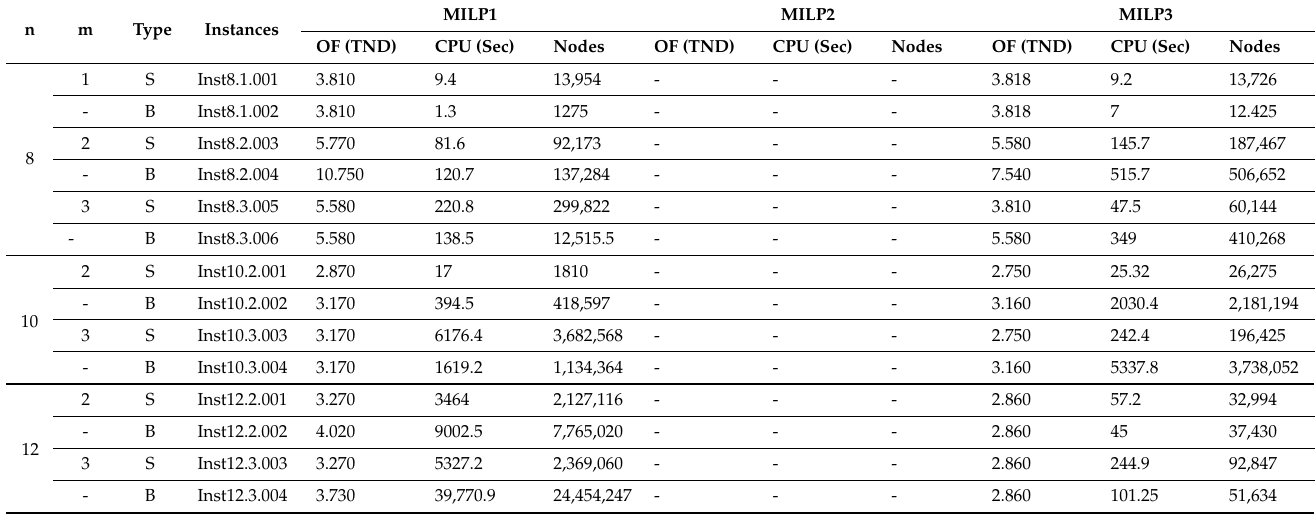
Table 2. Medium demand and moderate number of customers